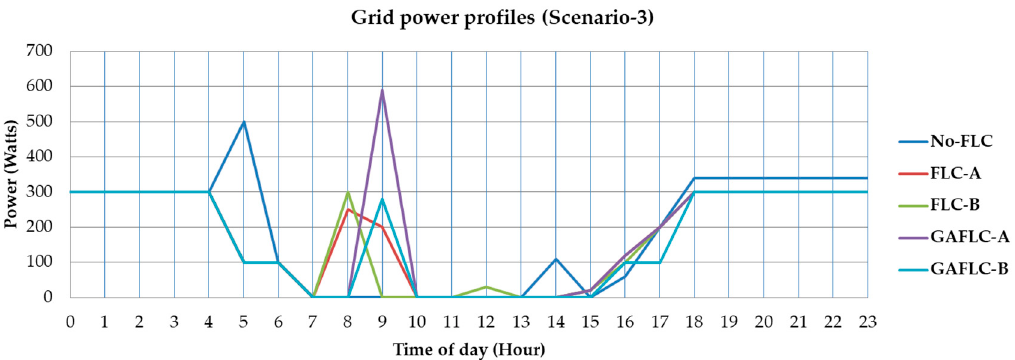
Figure 15. The grid power profiles in Scenario 3 (No-FLC, FLC-A, FLC-B, GAFLC-A, GAFLC-B).